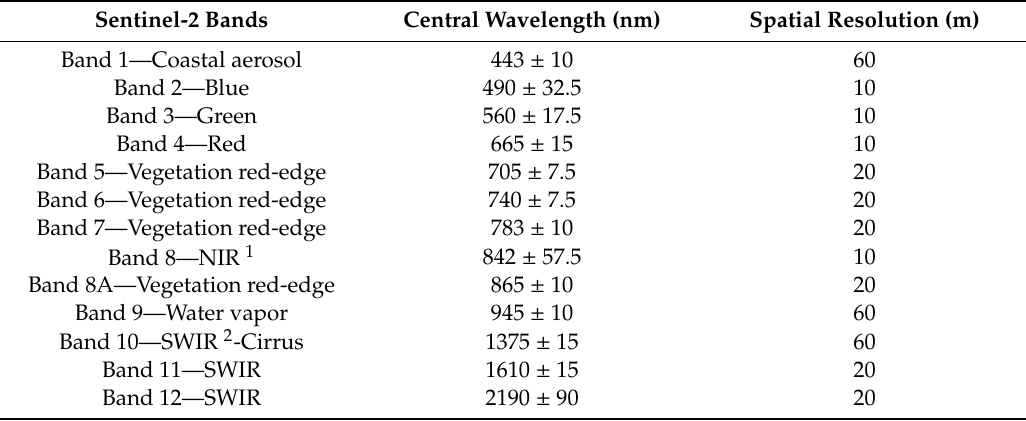
Table 2. Sentinel 2A / 2B MultiSpectral Instrument (MSI) data band information.